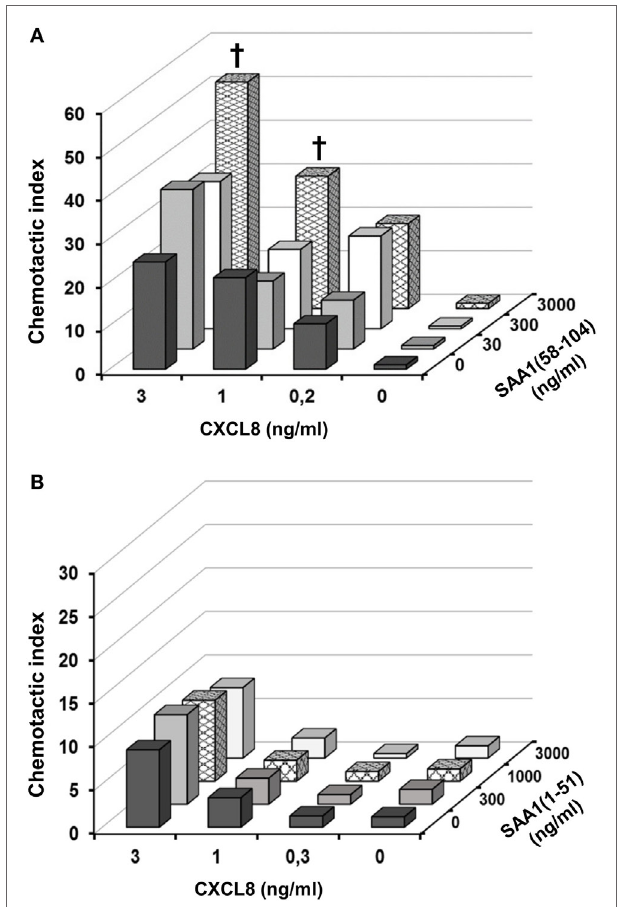
FigUre 7 | SAA1(58–104) cooperates with CXCL8 in neutrophil activation. (a) Neutrophils were treated with buffer, CXCL8 (5, 12.5, or 25 ng/ml), SAA1(58–104) (300 or 3,000 ng/ml), or a combination of CXCL8 and SAA1(58–104). Data from 8 to 16 independent experiments are expressed as the net percentage of blebbed plus elongated neutrophils ± SEM. Statistically significant differences compared with controls and statistically significant cooperation, determined by the Wilcoxon Sum Rank test, are indicated by asterisks (* p = 0.05; ** p < 0.01; and *** p < 0.001) or by a dagger ( † p < 0.05), respectively. (B) Bright field pictures (40 × magnification; scale bar 10 µm) illustrating the shape change of neutrophils after stimulation with buffer, SAA1(58–104) (3,000 ng/ml), CXCL8 (5 ng/ml), or the combination of SAA1(58–104) (3,000 ng/ml) and CXCL8 (5 ng/ml).